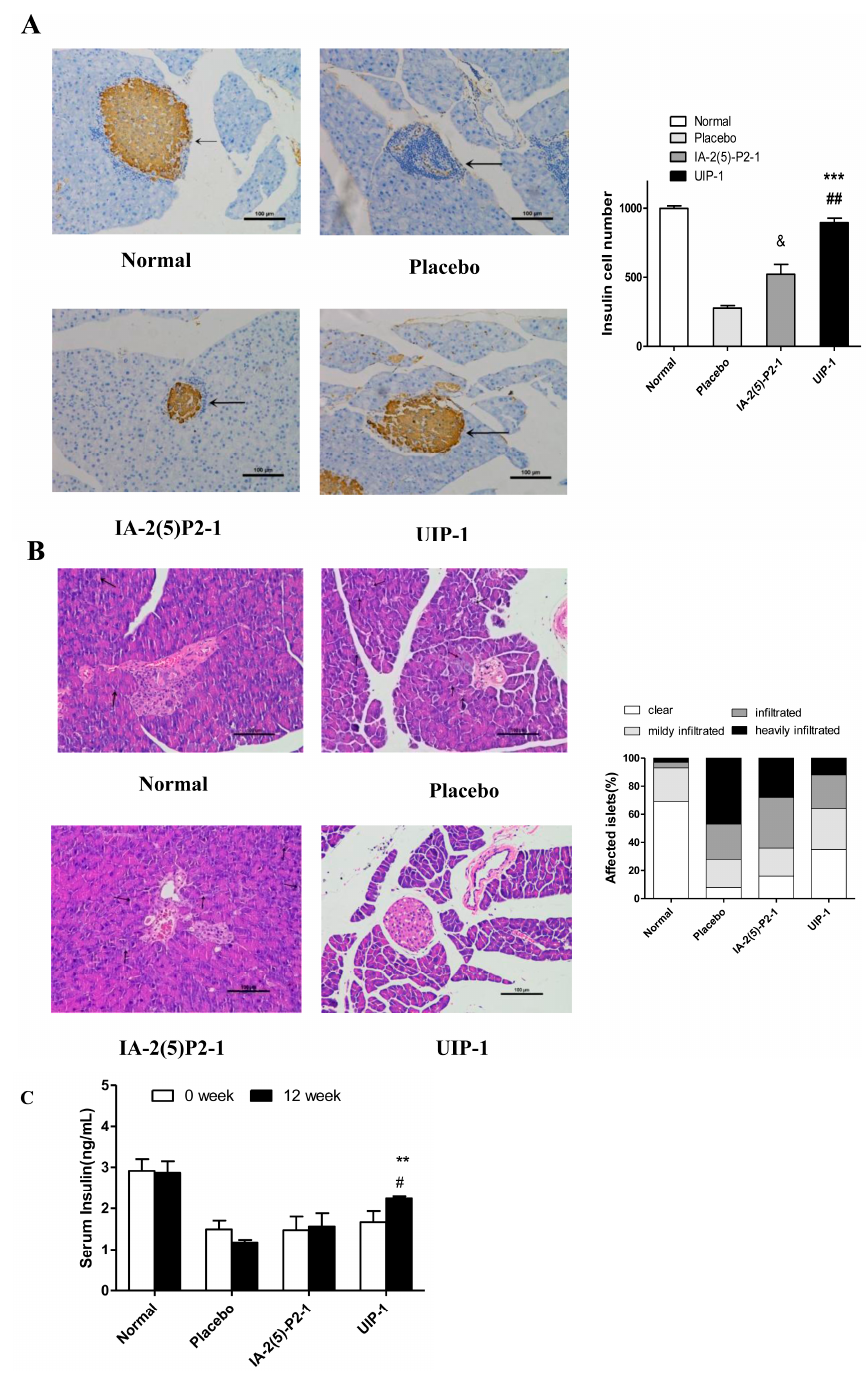
Figure 4. Histological examination of pancreas tissue. ( A ) Immunohistochemistry analysis of insulin with an anti-mouse insulin antibody in islets (200×) The black arrows showed the pancreatic island of mice; ( B ) HE staining of islets from pancreas tissues. The black arrows showed the inflammatory cells. Photomicrographs of representative islets from pancreas tissue (200×); ( C ) The level of serum insulin. Data are expressed as the mean ± SEM ( n = 3). ** p < 0.01, *** p < 0.001; UIP-1 versus placebo group. # p < 0.05, ## p < 0.01; UIP-1 versus IA-2(5)-P2-1 group. & p < 0.05; IA-2(5)-P2-1 versus placebo group, one-way ANOVA.